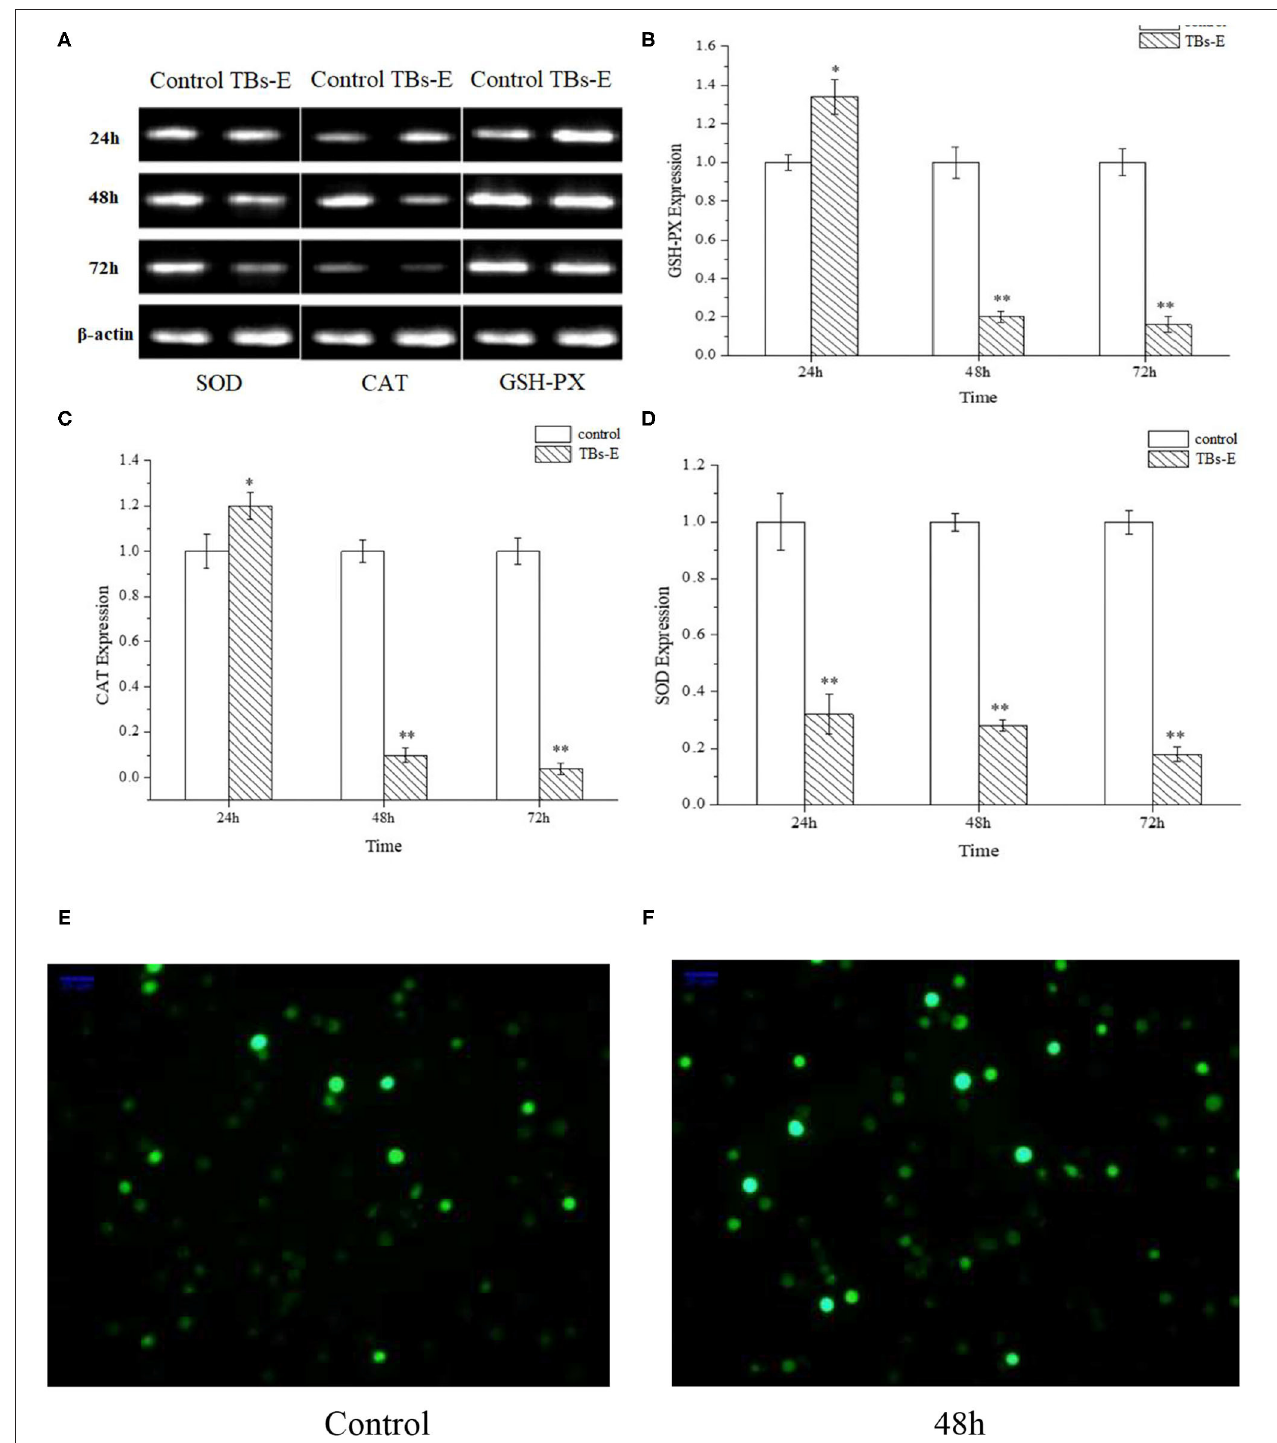
FIGURE 10 | Effects of TBs-E on the expression of the antioxidant enzyme genes in HT-29 cells and immunofluorescence assay to determine ROS in HT-29 cells after the TBs-E treatment (200X). HT-29 cells were treated with 500 µ g/ml of TBs-E for 24, 48, or 72h. After extracting the DNA and synthesizing the cDNA, the final PCR products were subjected to agarose gel electrophoresis (A) . The density of the bands was scanned and analyzed by Quantity One software (B–D) . * P < 0.05, ** P < 0.01, compared to the control group. (E) Control, (F) TBs-E treatment (48h).